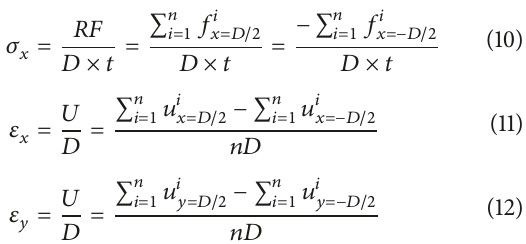
of the composite is periodic, which indicates that all the fibers of a 𝜃 𝑖 ±𝑛𝜋 orientation angle exert the same effect. According to this, 𝜌(𝜃 𝑖 ) can be flexibly calculated for large 𝜎 2